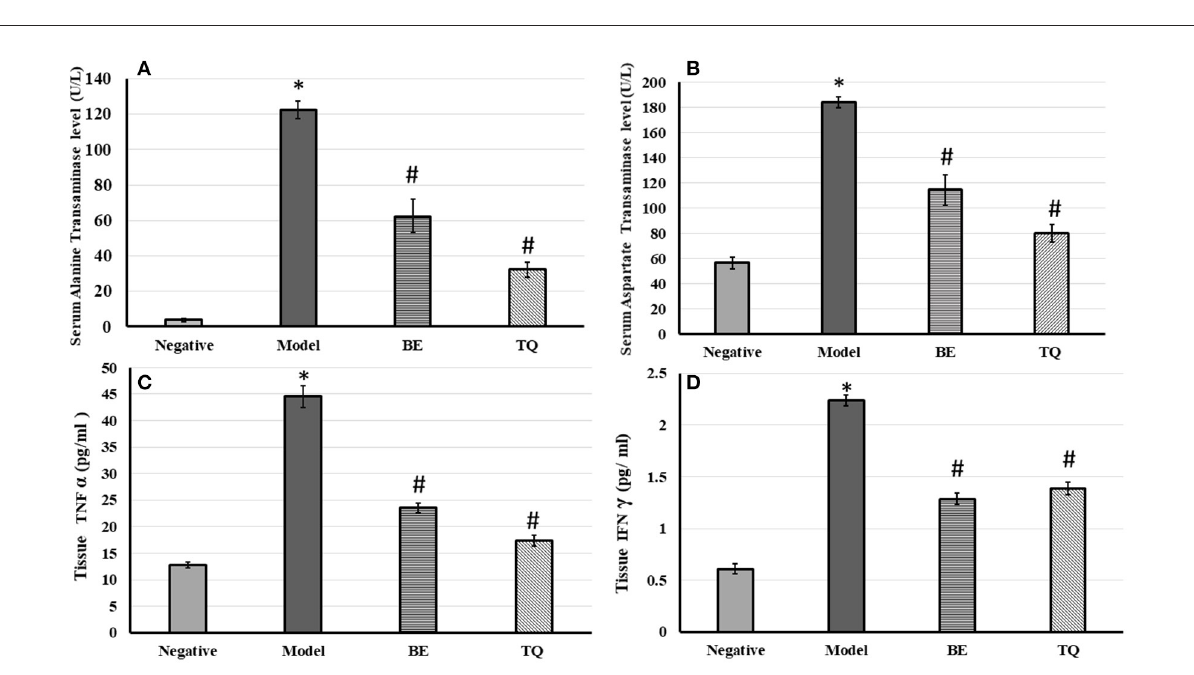
FIGURE2 The effects of BE (30 mg/kg/day) and TQ (25 mg/kg/day) on (A) serum ALT level; (B) AST level; (C) tissue TNF α expression and (D) tissue IFN- γ expression. * Denotes a significant difference compared to the negative group (p < 0.001). # Denotes a0101 significant difference compared to the model group ( p < 0.0010101). BE, Berbamine; TQ, Thymoquinone ( n =